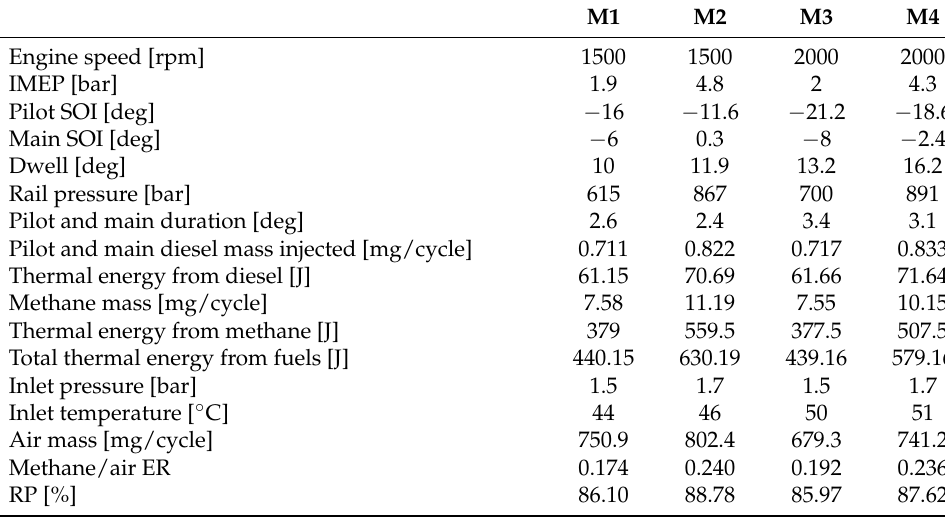
Table 4. Engine operating conditions for the cases with methane.